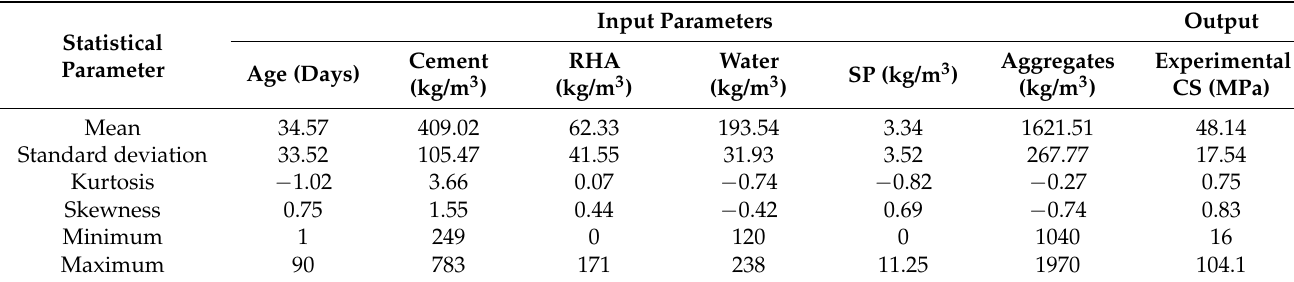
Table 2. Statistical analysis of input